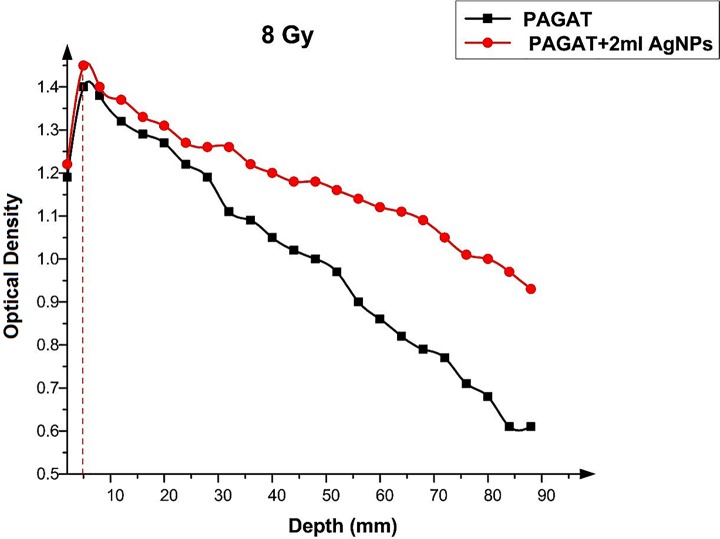
OD versus depth in the PAGAT polymer gel and PAGAT with Ag nanoparticles iraddiated by 8 Gy of 60Co.